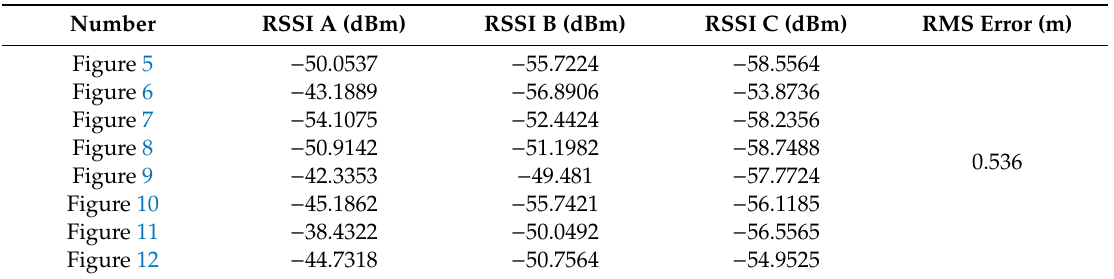
Figure 14. Hardware of Bluetooth low-energy (BLE) transmitter.